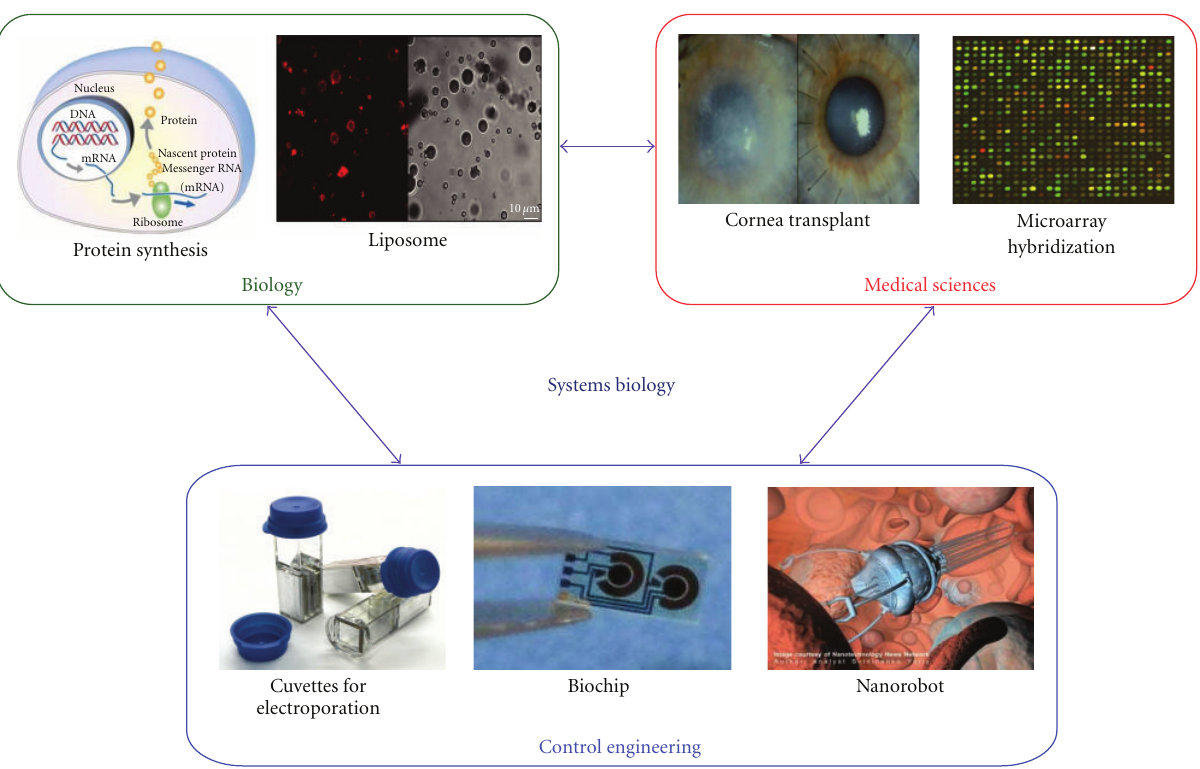
Figure 2: Systems biology is a cross-cutting research area connecting control engineering, biology, and medical science. Sources: protein synthesis http://www.anticancer.de/, liposome [8], corneal transplant http://www.avclinic.com/, microarray hybridization [9], cuvettes for electroportation http://www.en.wikipedia.org/, biochip http://www.clemson.edu/, nano robot